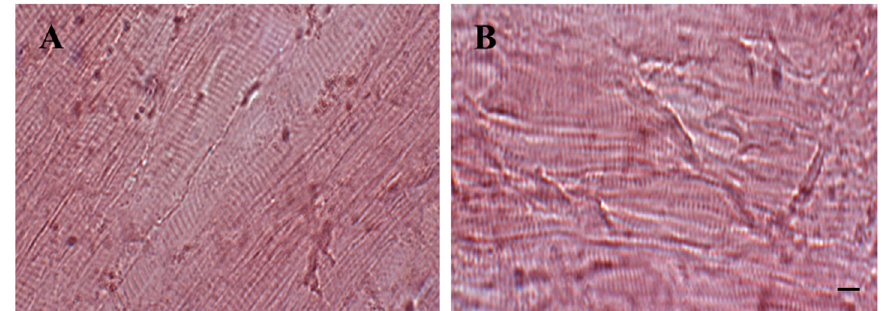
Figure 2. Hematoxylin–eosin staining of longitudinal sections of trout fillets. ( A ) uncoated fillet (UTF) after 12 day period of storage and ( B ) carrageenan coated fillet (CTF) after 12 days of storage; CTF and ACTF gave similar results. Scale bars: A,B: 10 µ m. Sections are representative of three trout analyzed for each experimental group.